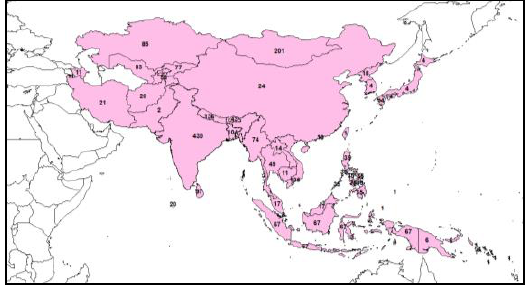
Figure 4. Countries benefited with no. of